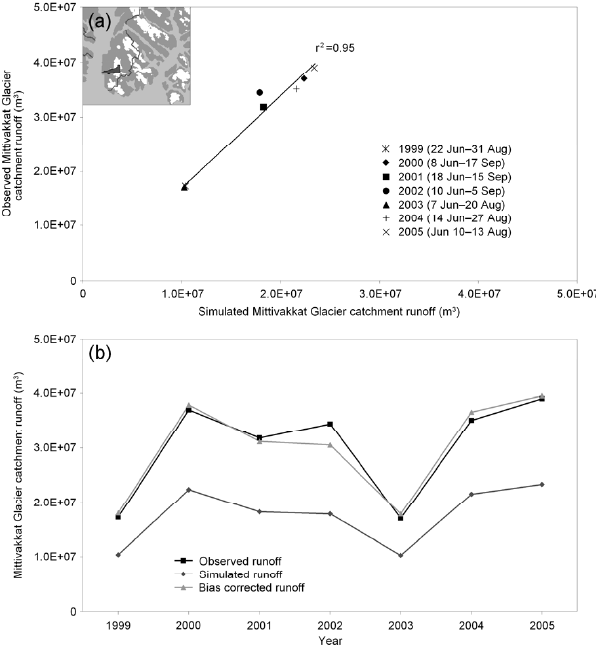
Figure 3: (a) Observed and simulated Mittivakkat Glacier catchment runoff from 1999–2005. The linear regression (forced through zero) was used for bias correction of the Sermilik Fjord simulated runoff. Be aware that the annual observed runoff periods are different. The inset figure indicates the general location of the Mittivakkat Glacier catchment (black polygon) within sub-catchment area 1 (for a general location of the sub-catchments see Fig. 4a) inside the Sermilik Fjord catchment; and (b) observed, simulated, and bias corrected runoff from the Mittivakkat Glacier catchment from 1999–2005.